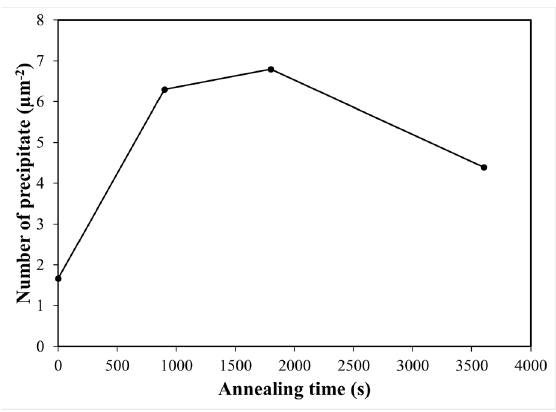
Figure 5. Effect of annealing time on the number of precipitates per area.